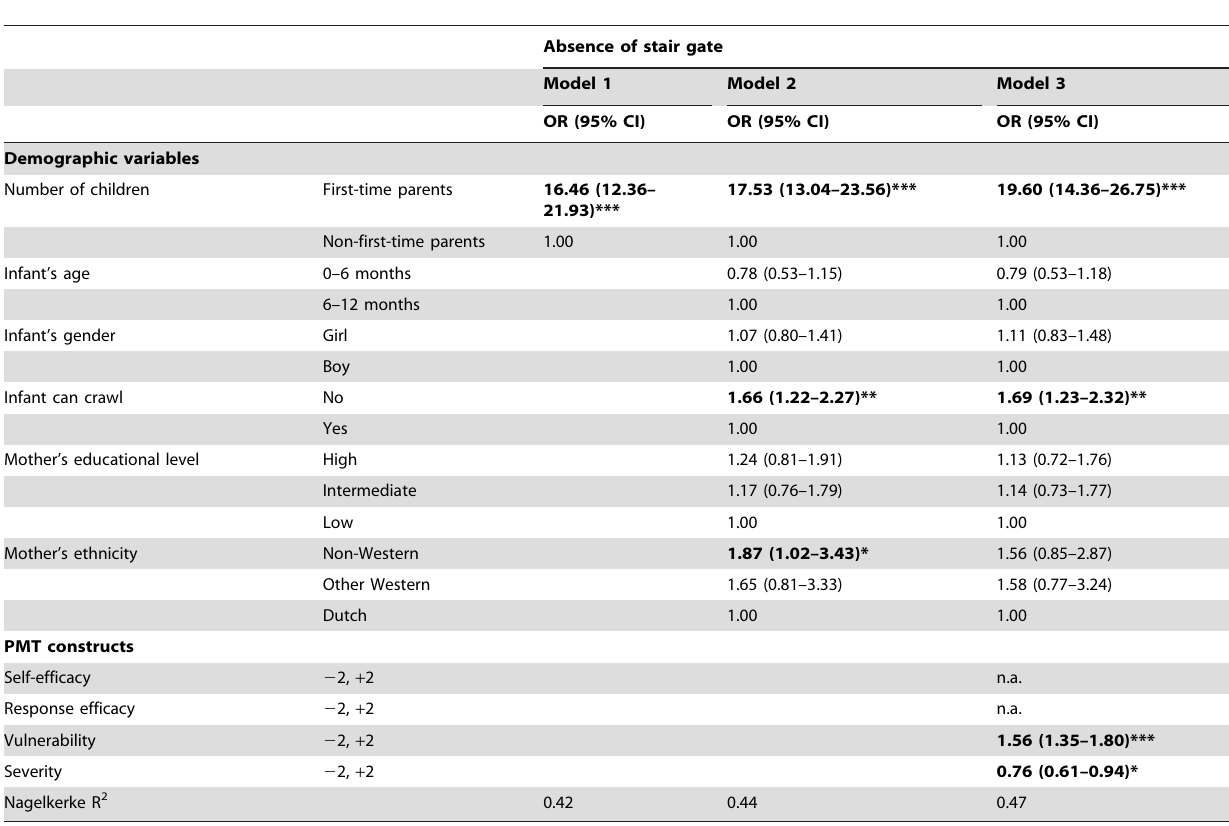
Table 3. Odds ratios (OR) and 95% confidence intervals from multiple logistic regression analyses with reported absence of stair gate as dependent variable and number of children (Model 1), other demographic variables (Model 2) and Protection Motivation Theory (PMT) variables (Model 3) as independent factors in a subgroup of parents with a main staircase present in their house (n=1245).